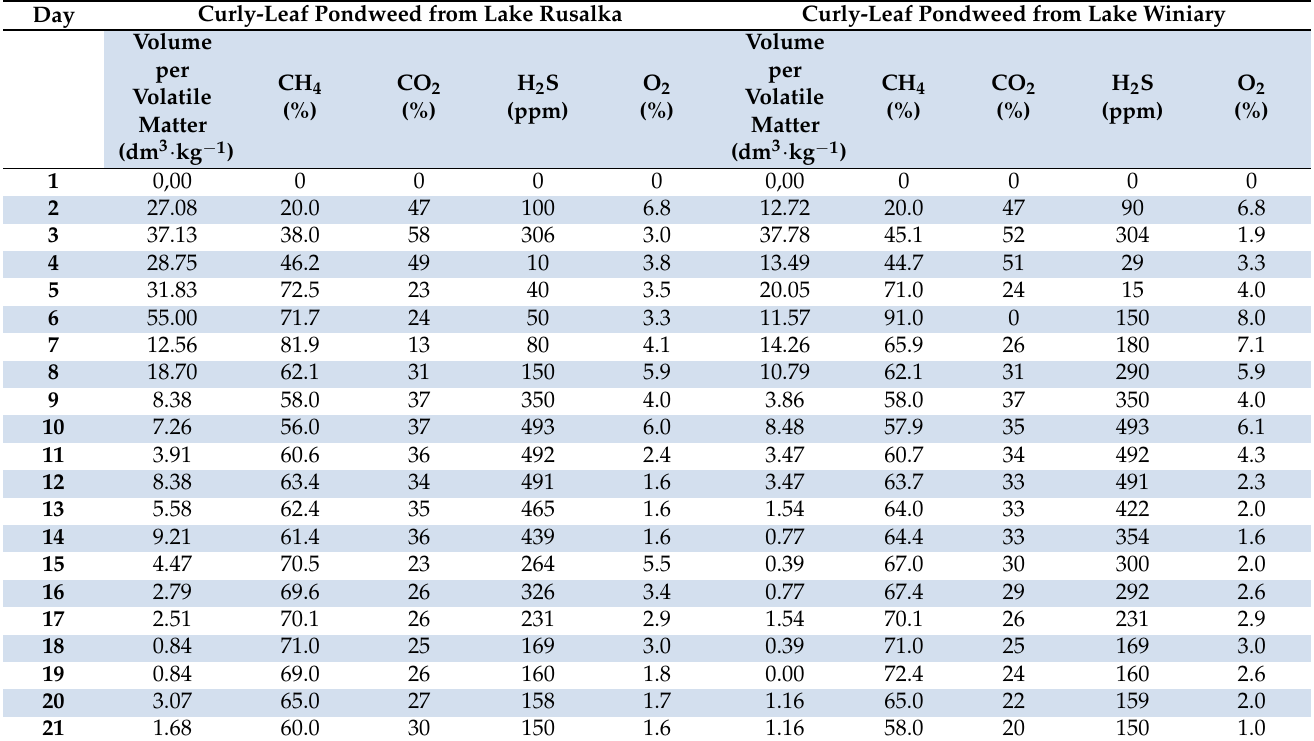
Table 3. Results of the measurements of individual components during biomethane fermentation of curly-leaf pondweed from Lake Rusalka and Lake